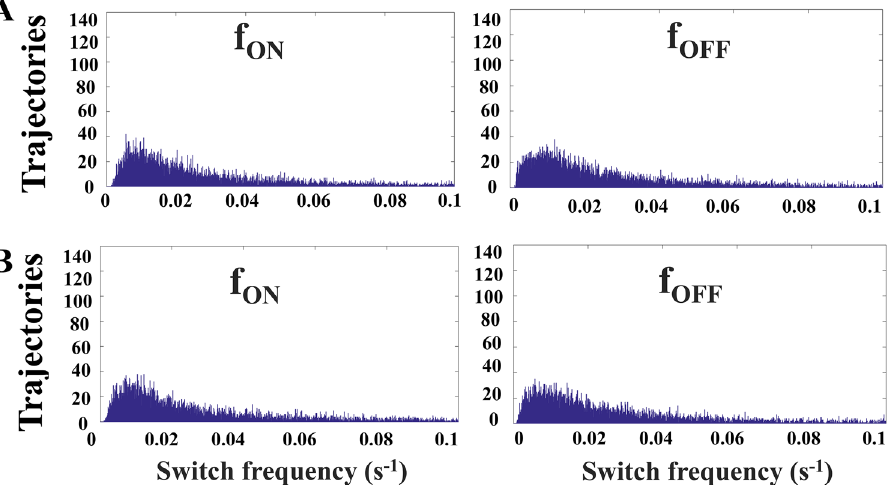
Figure 4. The f ON represents the reciprocal of the time required from the OFF state to the ON state and f OFF is from the ON to the OFF. We discuss the switching frequency of DNA for two cases in Fig. 3A,B. There are two noise intensities of TF, ( A ) low and ( B ) high. Interestingly, both of them have nearly the same distribution of f ON and f OFF .